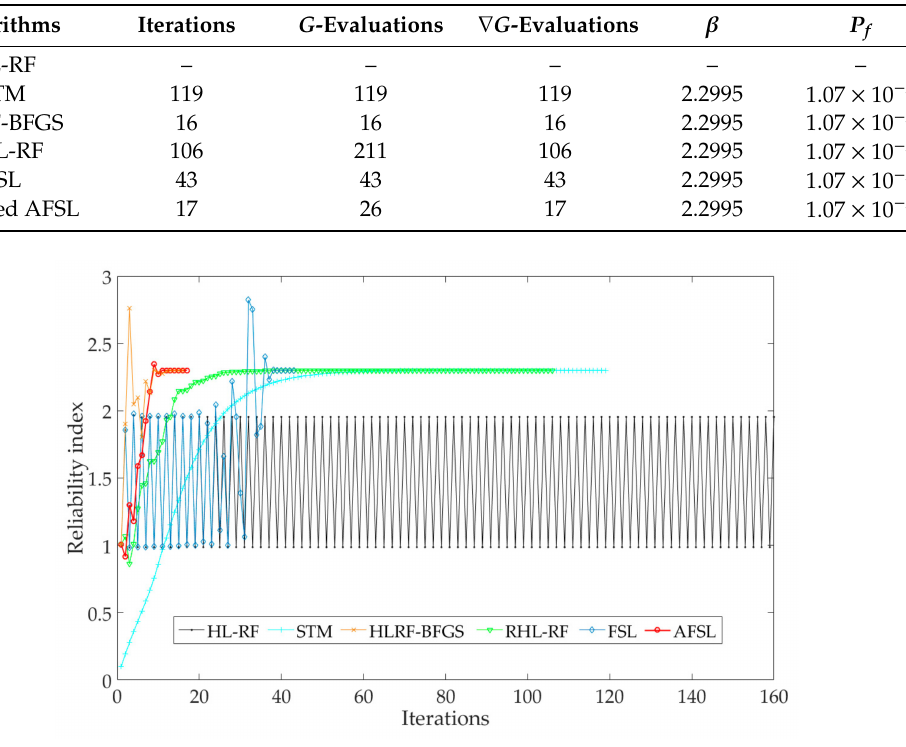
Figure 6. Iterative processes of reliability index for Example